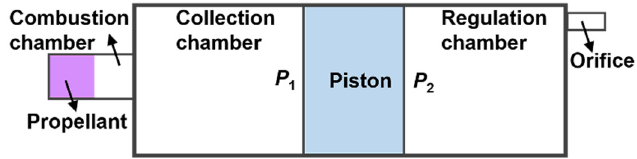
Figure 1. Schematic diagram of the pressure maintenance principle.